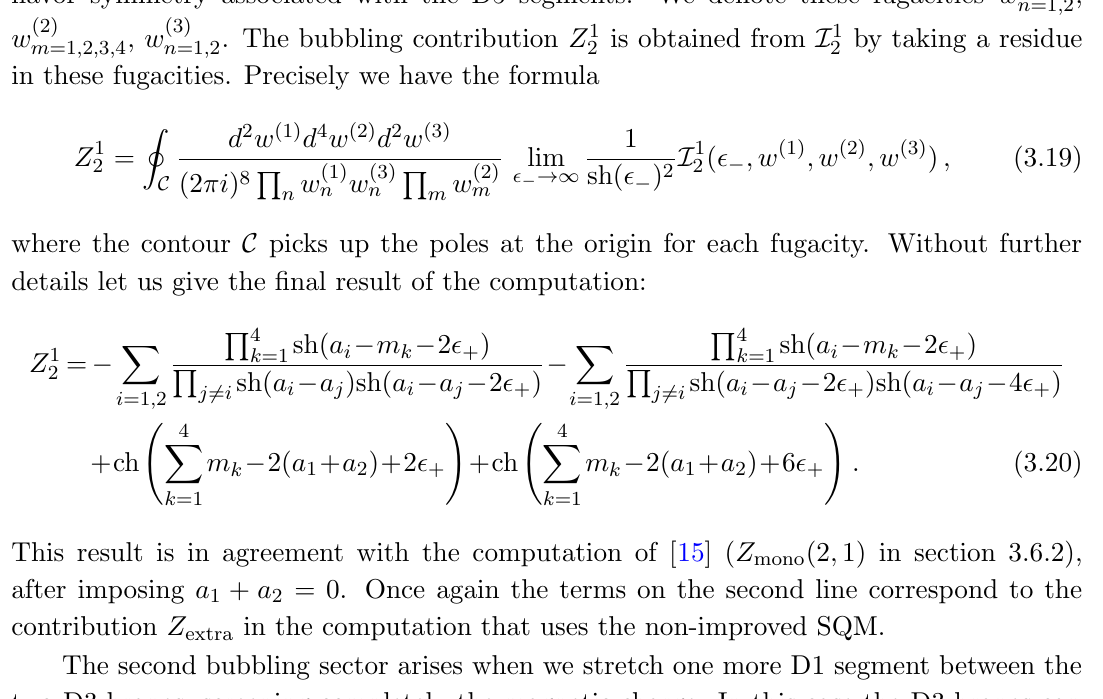
Figure 16 . Brane setup and improved SQM for the bubbling sectors (a) v 1 for Z 1 for Z 0 2